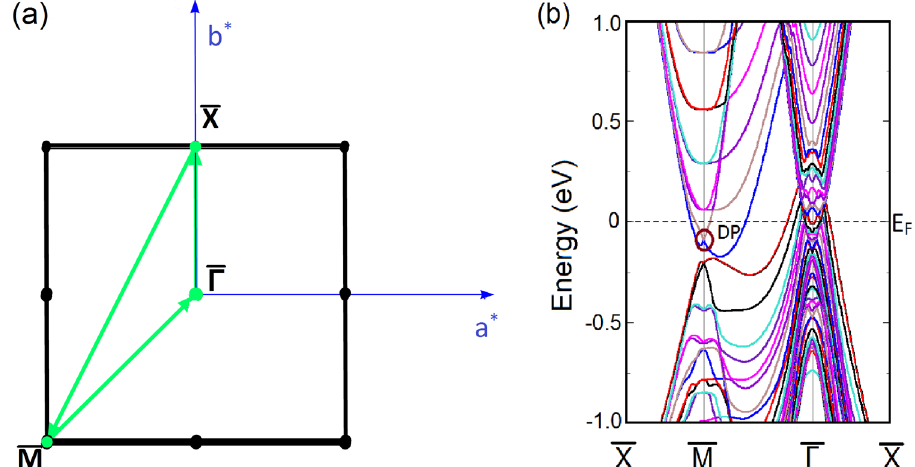
Figure 3. ( a ) Projection of the (001) surface Brillouin zone. a * and b * denote the reciprocal lattice vectors.( b ) The surface band structure of LaSb along the high symmetry k-path ( X - M - Γ - X ) as shown in ( a ). The Dirac point is encircled and is denoted by DP. Presence of odd number of gapless Dirac cones at the M -point on the (001) surface suggests that LaSb may have a non-trivial topological